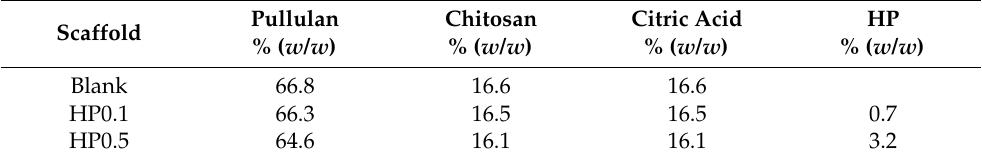
Table 1. Scaffolds quali-quantitative